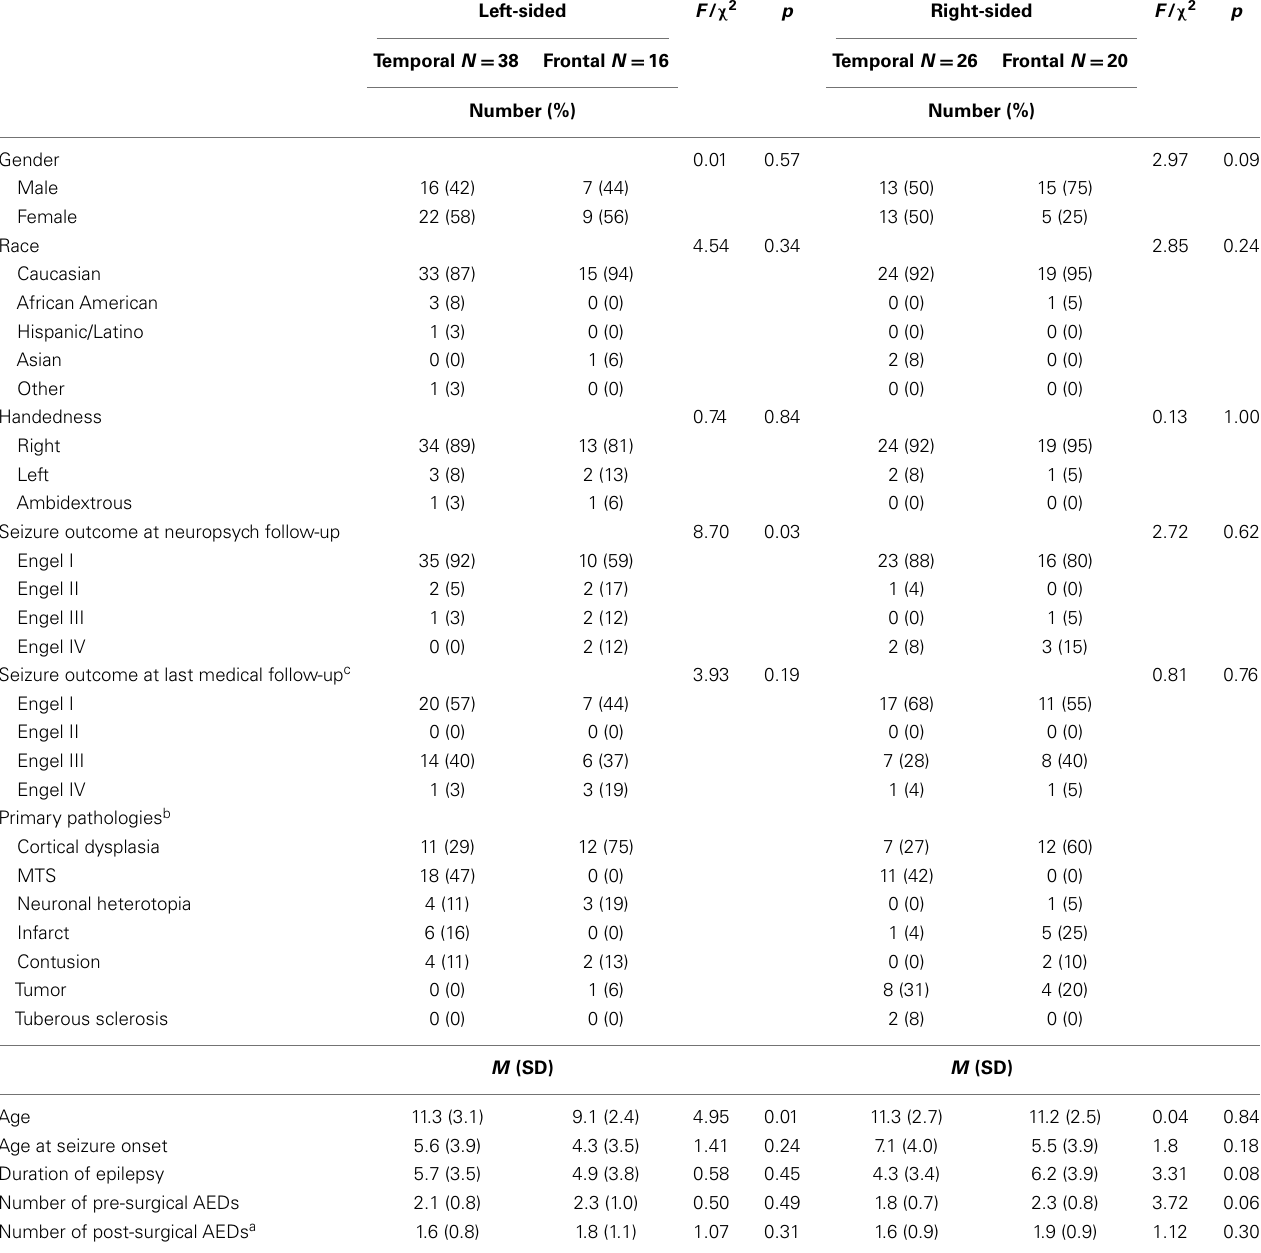
Table 1 | Summary of demographic and seizure variables for study groups